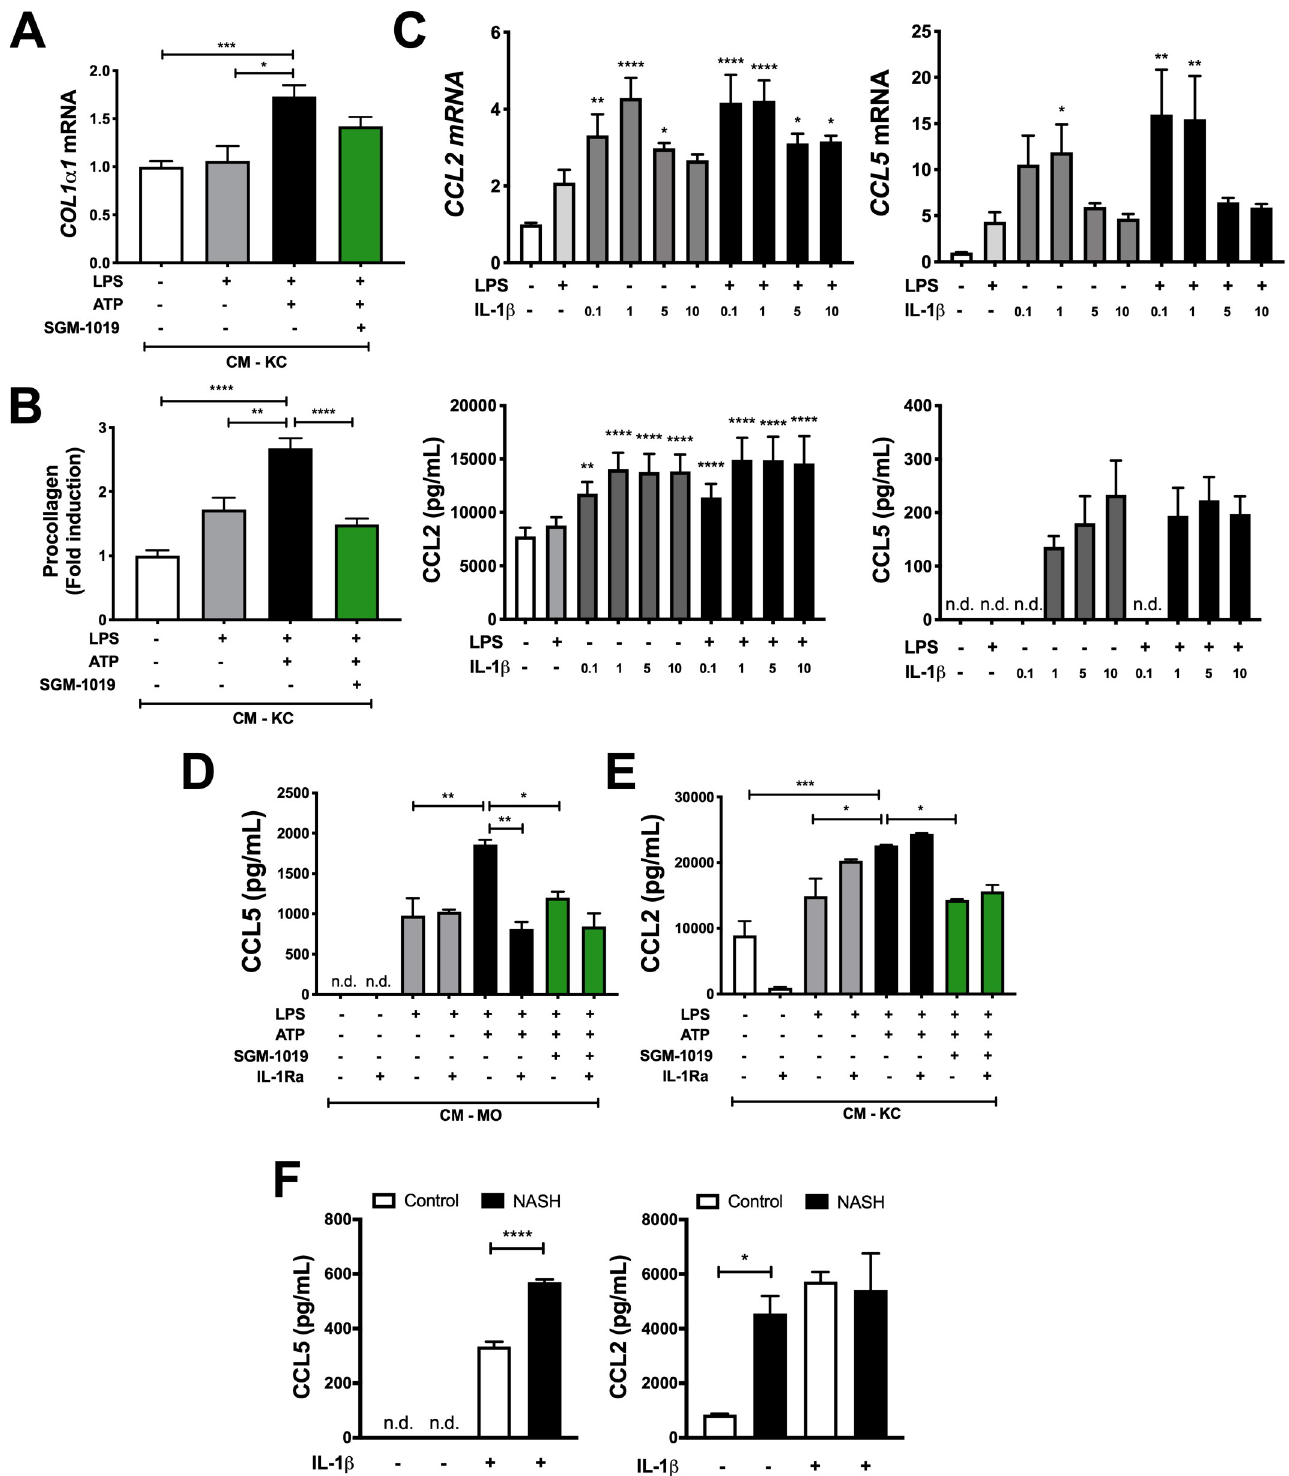
Fig 7. P2RX7-mediated IL-1 β enhances procollagen and CCL2/CCL5 chemokine secretion in HSCs. (A) Relative expression of Col1 α 1 and (B) procollagen levels in HSCs cultured with CM-KC treated with LPS, ATP ± SGM-1019 (CM-KC). (C) Relative expression of CCL2 / CCL5 and CCL2/CCL5 levels in culture media from HSCs treated with LPS ± increasing concentrations of IL-1 β . (D) CCL5 and (E) CCL2 levels in HSCs cultured with CM-MOs or CM-KCs treated with LPS, ATP ± SGM-1019 and/or IL-1Ra, respectively. (F) CCL5 and CCL2 levels in HSCs isolated from control and NASH-affected donor treated with IL-1 β